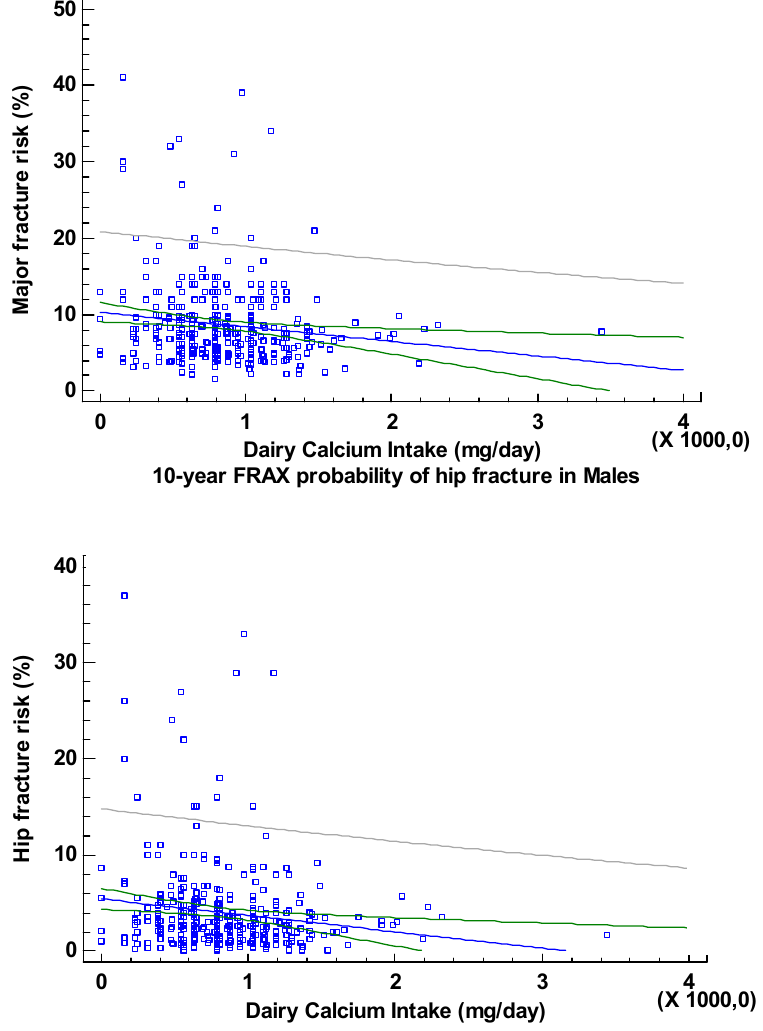
Figure 2. Relationship between daily dairy calcium intake and 10-year FRAX probability of osteoporotic major fracture or hip fracture in